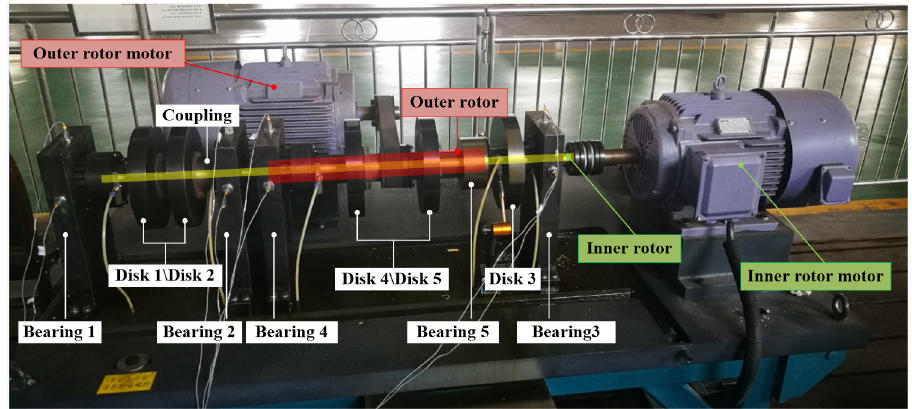
Figure 17. Experimental setup of a dual-rotor system.